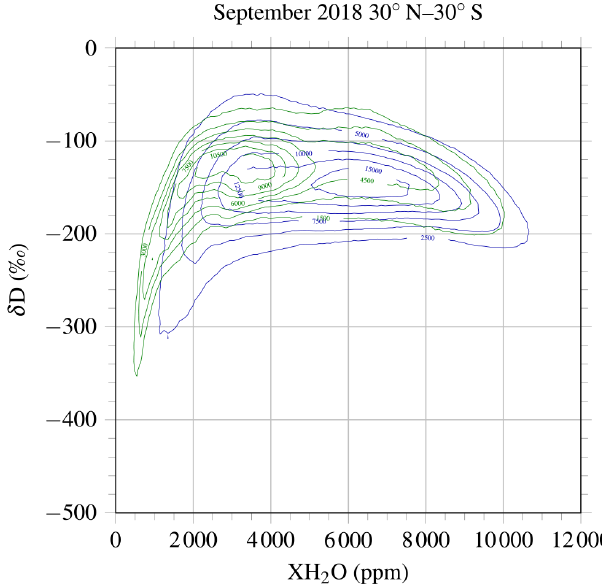
Figure 17. (H 2 O, δ D) phase space for all valid measurements in September 2018 in the latitude band 30 ◦ N–30 ◦ S. Green isolines correspond to data over land and blue isolines to data over